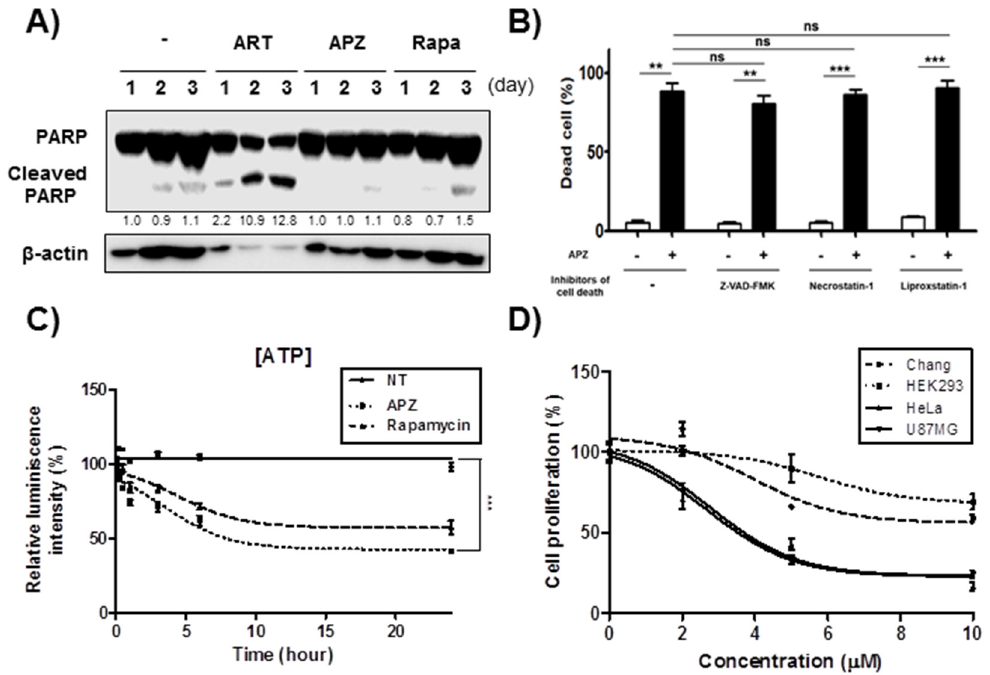
Figure 2. APZ triggers cancer-specific autophagic cell death. ( A ) Treatment with APZ (5 μ M) did not induce poly (ADP-ribose) polymerase (PARP) cleavage in HeLa cells for 24 or 72 h of treatment. Artesunate (ART, 25 μ M) was used as a positive control for apoptosis. ( B ) Effect of various inhibitors on cell death induced by APZ treatment. Cells were pretreated with DMSO (control) or the inhibitors of cell death, Z-VAD-FMK (50 μ M), necrostatin-1 (10 μ M), and liproxstatin-1 (100 nM) for 1 h before treatment with APZ (10 μ M) for 24 h. The percentage of nonviable cells was assessed by trypan blue staining. Values represent mean ± SEM from three independent experiments. ( C ) Adenosine triphosphate (ATP) levels in HeLa cells were measured using an ATPlite luminescence assay system. ATP levels decreased following treatment with APZ (5 μ M) or rapamycin (10 μ M) for 24 h. Values are means ± SEM; n = 3. ** p < 0.01, *** p < 0.001. ( D ) Effect of APZ on the proliferation of normal cell lines, including Chang and human embryonic kidney (HEK293), and cancer cell lines, including HeLa and U87MG. All cells were treated with APZ (1–10 μ M) for 48 h, and cell growth was measured using an 3-(4,5-dimethylthiazol-2-yl)-2,5-diphenyl tetrazolium bromide (MTT) colorimetric assay. N = 4 means ± SE. More details of western blot, please view at the supplementary materials.